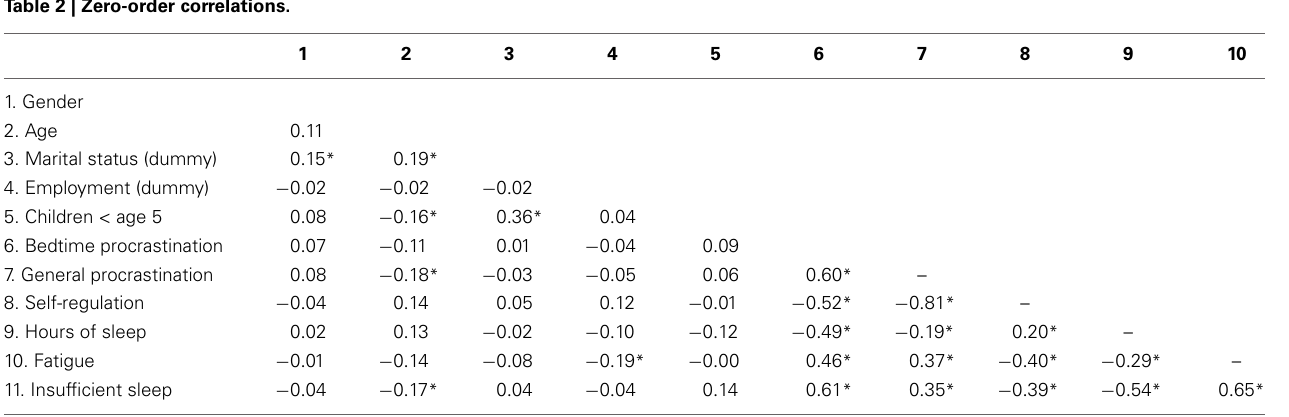
Table 2 | Zero-order